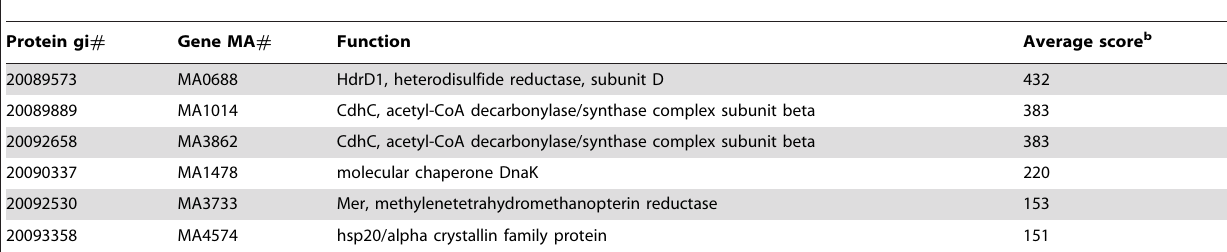
Table 2. HdrD1 protein:protein interactions detected by Mass Spectrometry a .